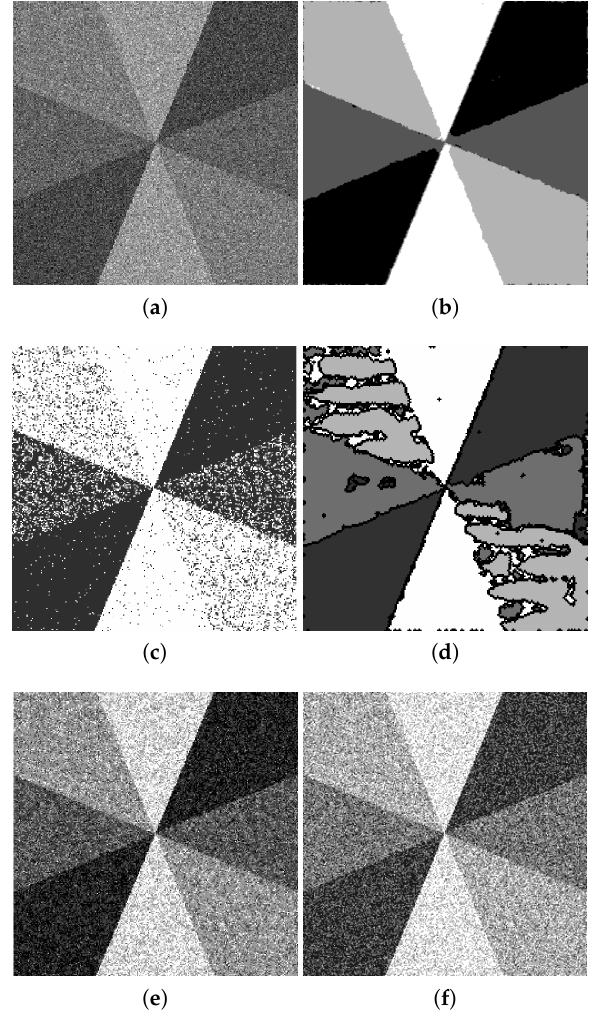
Figure 9. Comparison to other methods: ( a ) the input image (noisy ‘Sectors’ images); segmentation output of ( b ) the proposed method, ( c ) graph cut method, ( d ) Vese–Chan method, ( e ) fuzzy segmentation method, ( f )